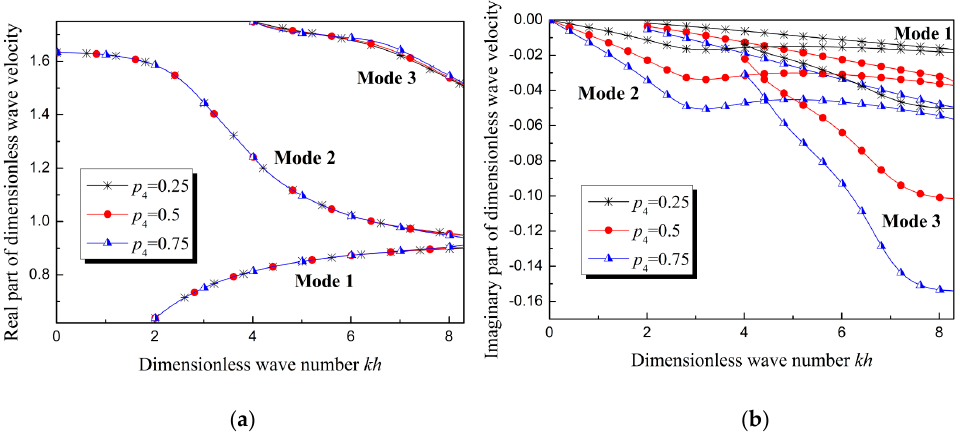
Figure 9. Wave velocity of Lamb waves in homogenous viscoelastic film and in FGVM film (with only the relative viscosity coefficient varying linearly and identically). (a) Real part, (b) imaginary part.